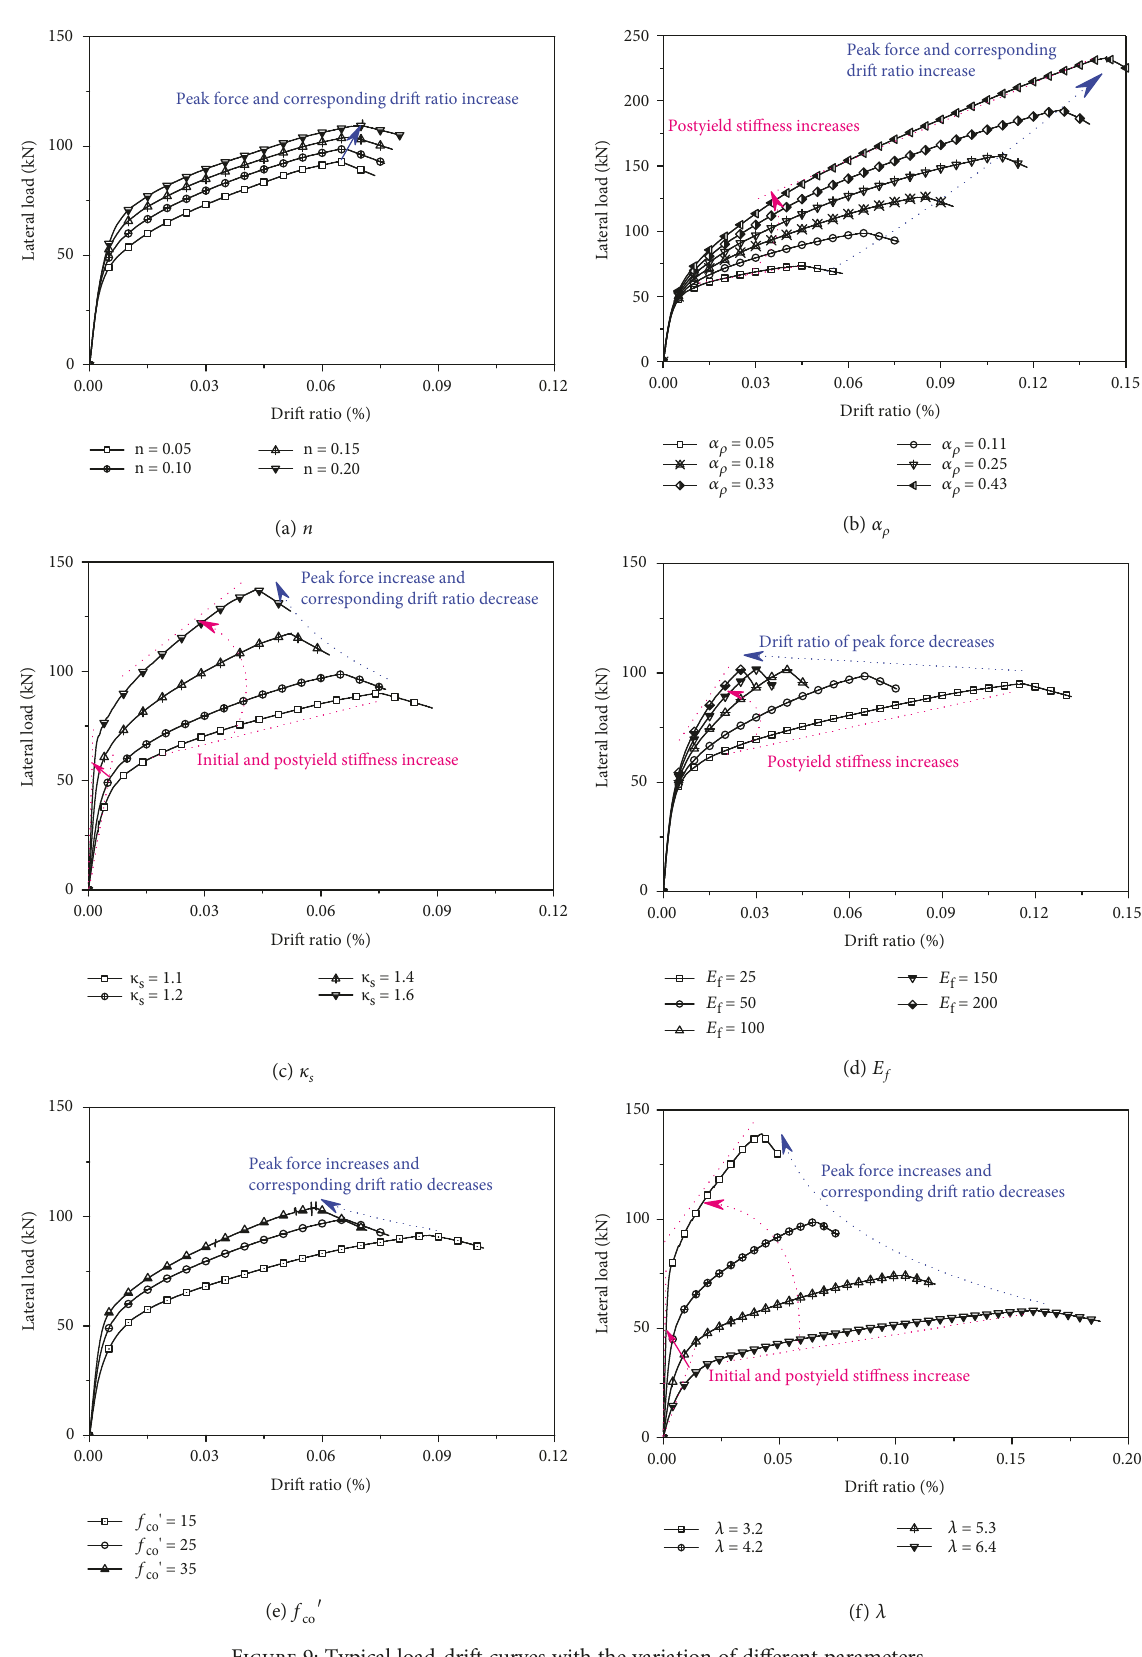
Figure 9: Typical load-drift curves with the variation of di ff erent